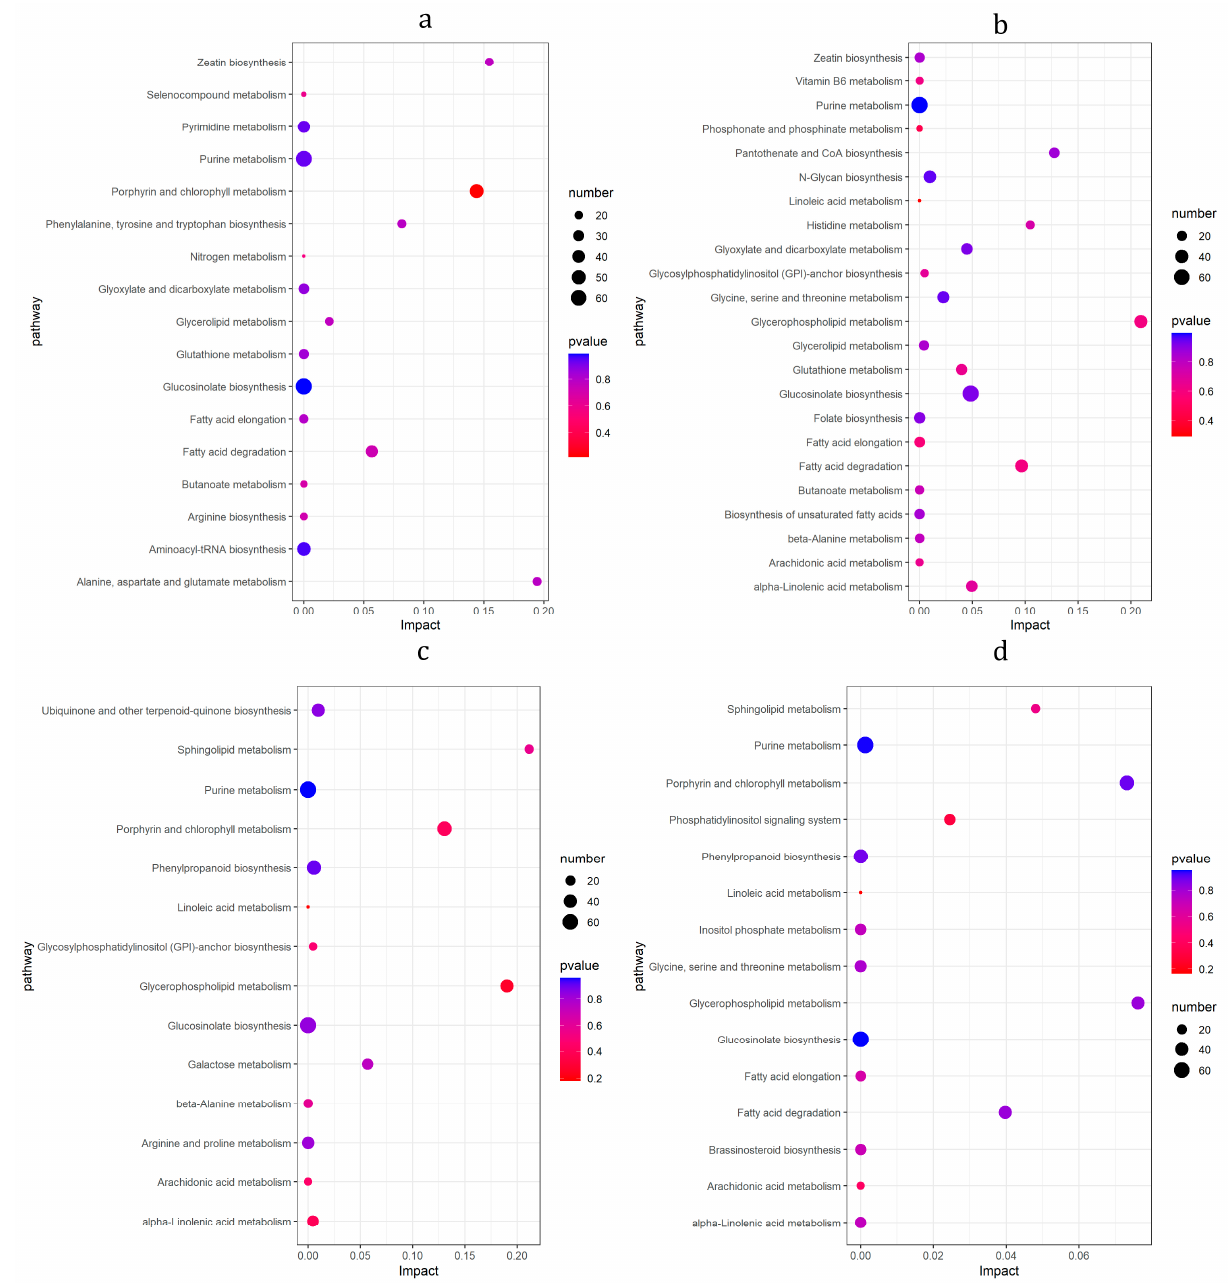
Figure 9. KEGG enrichment analysis of DMs. Horizontal is impact and ordinate is pathway. The size of the dot represents the number of DMs. Different colors of dots represent different p -adjust values. ( a ) bx1 vs. ck1; ( b ) bx2 vs. ck2; ( c ) bx3 vs. ck3; ( d ) bx4 vs. ck4.